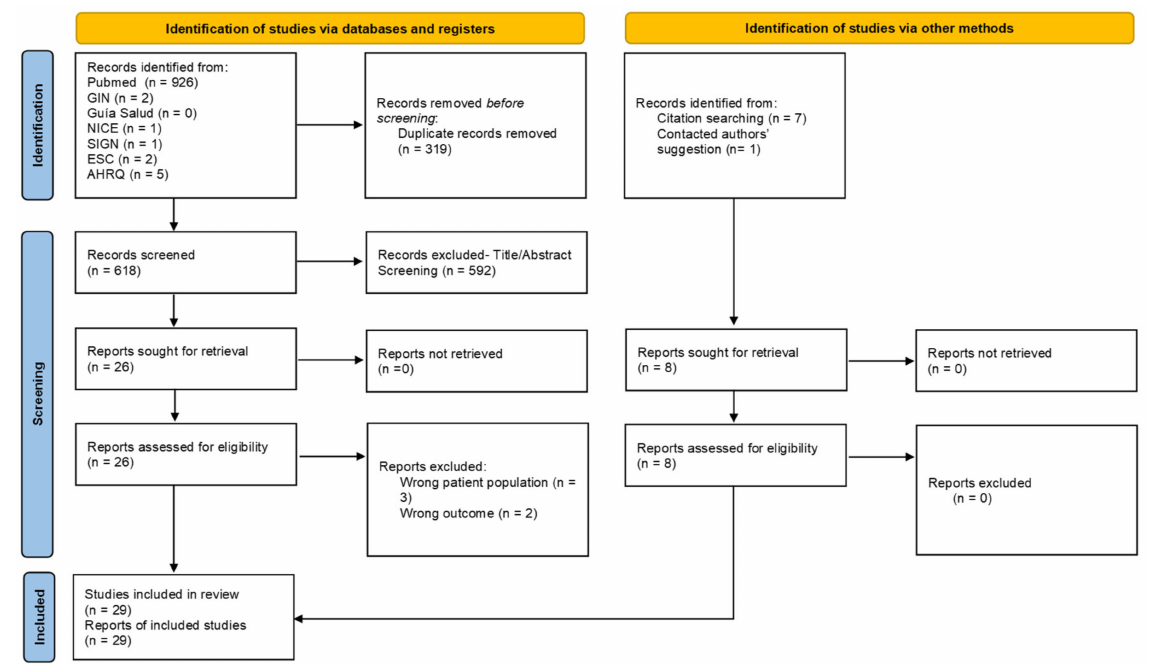
Figure 1. PRISMA 2020 flow diagram of the databases and registry search performed for the system- atic literature